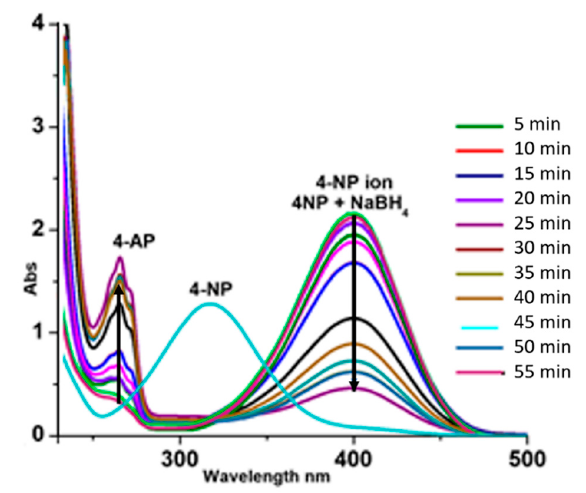
Figure 2. Absorption spectra of the reduction of 4-NP catalysed by complex 1 over time.